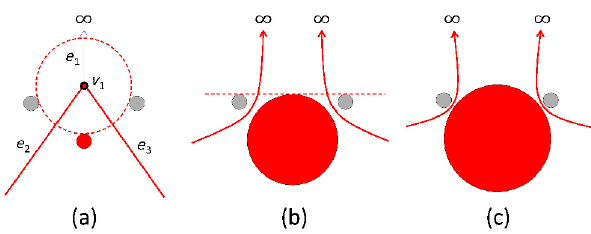
Fig. 14 During expansion of a special site (red), the cell vertex v 1 collides with neighbor vertex v 2 , causing a topology change.